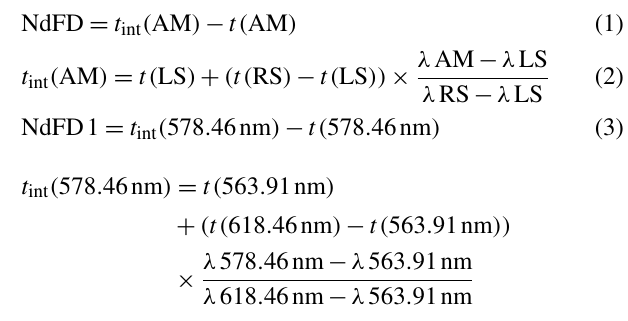
Table 2. The absorption maxima and left and right shoulders of the three absorption features of monazite-bound neodymium used for each NdFD